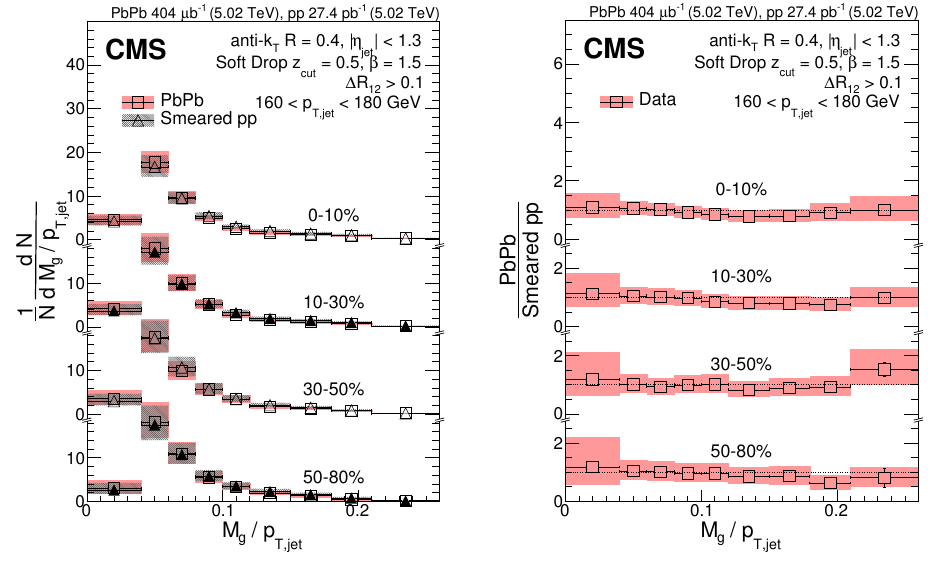
Figure 4 . (left) The centrality dependence of M g =p jet for the (0 : 5 ; 1 : 5) SD setting. Results are compared to the smeared pp spectra. (right) The ratio of PbPb data over smeared pp data. The heights of the vertical lines (colored boxes) indicate statistical (systematic) uncertainties. Statistical uncertainties are less than the marker sizes in most bins.